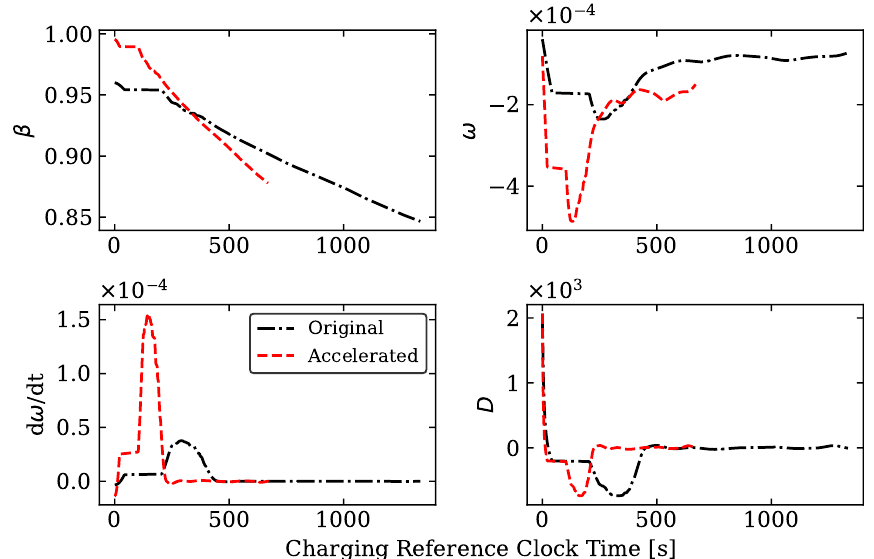
Figure 12. Comparison of charging mode at the inlet location, phase 2. The comparison of the scaled process curves in Figure 13 shows that curve separation occurred in both phases. This was expected because the λ A value was not exactly 1.0 and the shift of the curve was more prominent in the second phase, primarily due to the short time interval that was used for the analysis, which emphasized the separation more. In the first phase, the separation became more pronounced as the charging phase evolved. This showed that slight deviations from the ω -strain requirement of λ A = 1 could result in a process being scaled more by 2–2 affine scaling. However, the matched ˜ Ω magnitudes indicated that the transient aspect of the process time was preserved between the two cases. If the effect parameter values and normalized thermocline temperatures were to be divided by their corresponding scaling ratios of λ A = 1.037, the data points would overlap perfectly, which is an indication of perfect similitude.